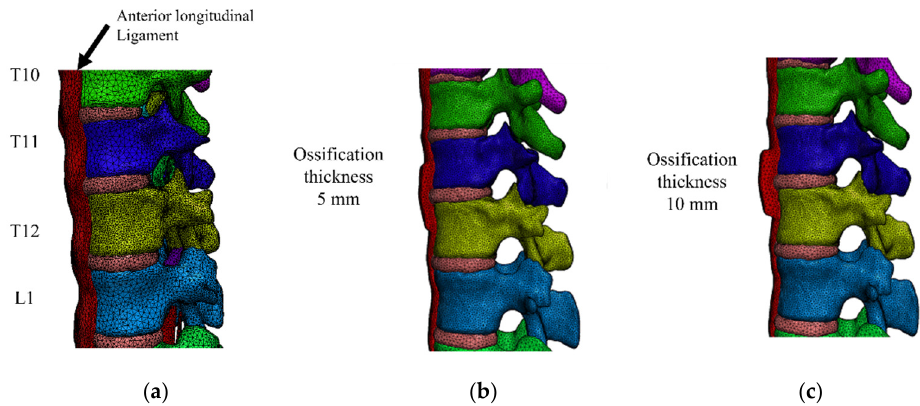
Figure 3. ( a ) In the diffuse idiopathic skeletal hyperostosis model, the anterior longitudinal ligament had the property of cortical bone. In addition, the thickness of ossification of T11–T12 was created at ( b ) 5 mm and ( c ) 10 mm.